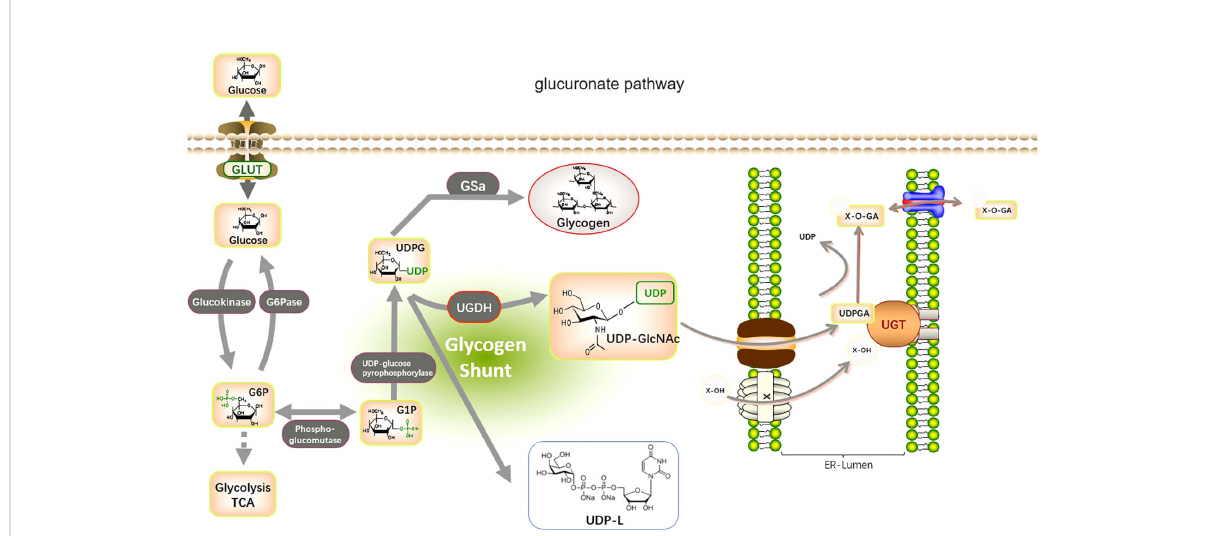
FIGURE 2 Metabolic pathways involved in glucuronidation by UGTs. The glucuronate pathway is a branched pathway of sugar metabolism with a small fl ux. The fi rst stage of the glucuronate pathway is the isomerization of the glycolytic intermediate, glucose 6-phosphate, to produce glucose 1- phosphate. This is then reacted with UTP to produce UDP-glucose. The catalytic enzymes are phosphoglucomutase (PGM) and UDP-glucose pyrophosphorylase (UGP). UDP-glucose is an important branch point of sugar metabolism. It can be used for the synthesis of UDP-glucuronide, UDP-galactose, and also as an entry point for polysaccharide synthesis. UDP-glucose is catalyzed by UDP-glucose dehydrogenase (UGDH) to produce UDP-glucuronide. This reaction involves two successive oxidation steps that oxidize the terminal hydroxymethyl group of glucose to a carboxyl group while generating two NADH. UDP-glucuronide is an important substance used by the liver for detoxi fi cation and can react with many fat-soluble substances ( Glucuronidation ). this reaction is catalyzed by UDP-glucuronyl transferase (UGTs) in the endoplasmic reticulum membrane, and the hemiacetal hydroxyl group of glucuronide can be combined with a variety of substances containing functional groups such as hydroxyl, carboxyl, amino, and sulfhydryl groups to produce esters or glycosides, which are excreted from the bile and